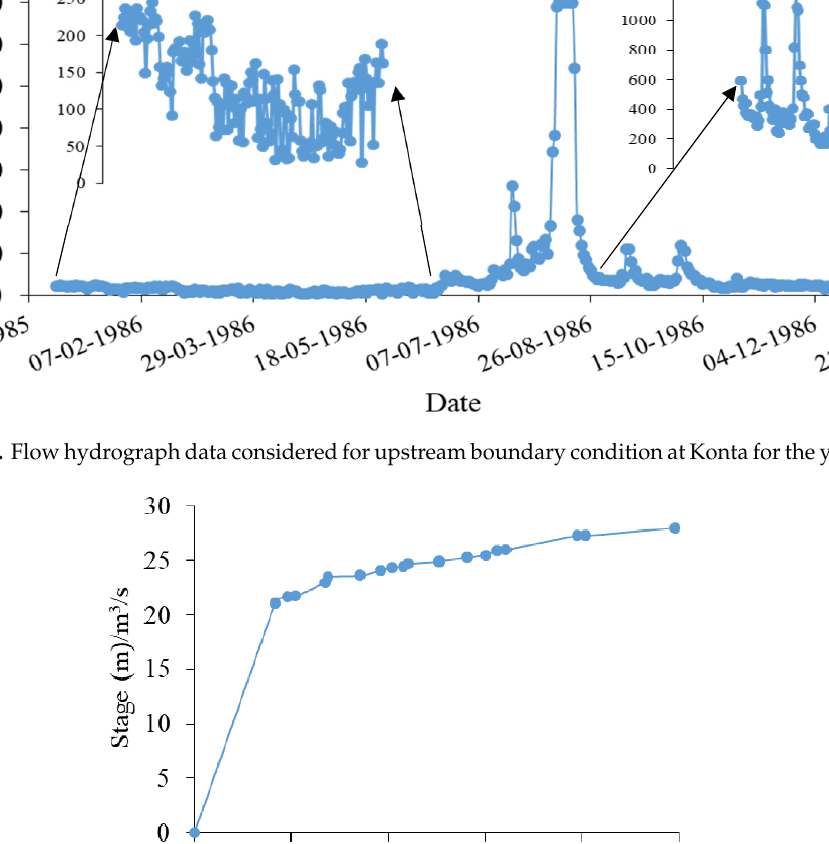
Figure 5. Flow hydrograph data considered for upstream boundary condition at Dummugudem for the year 1986